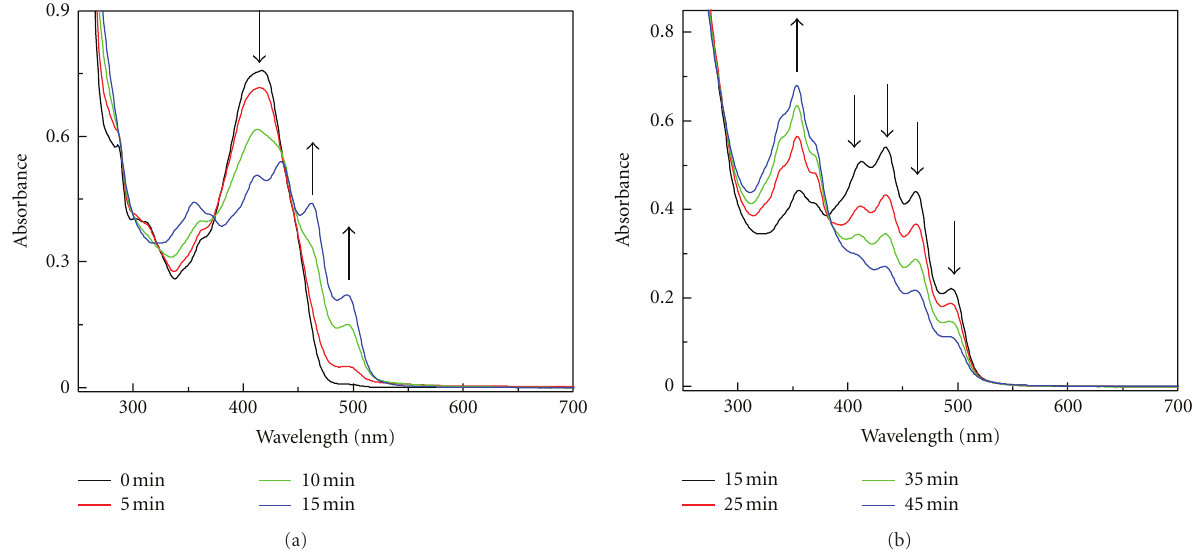
Figure 5: Electronic absorption spectra obtained during photolysis of dye 1 (0.1mM) in CH 2 Cl 2 in the presence of air. Irradiation intensity 6 × 10 16 quants − 1